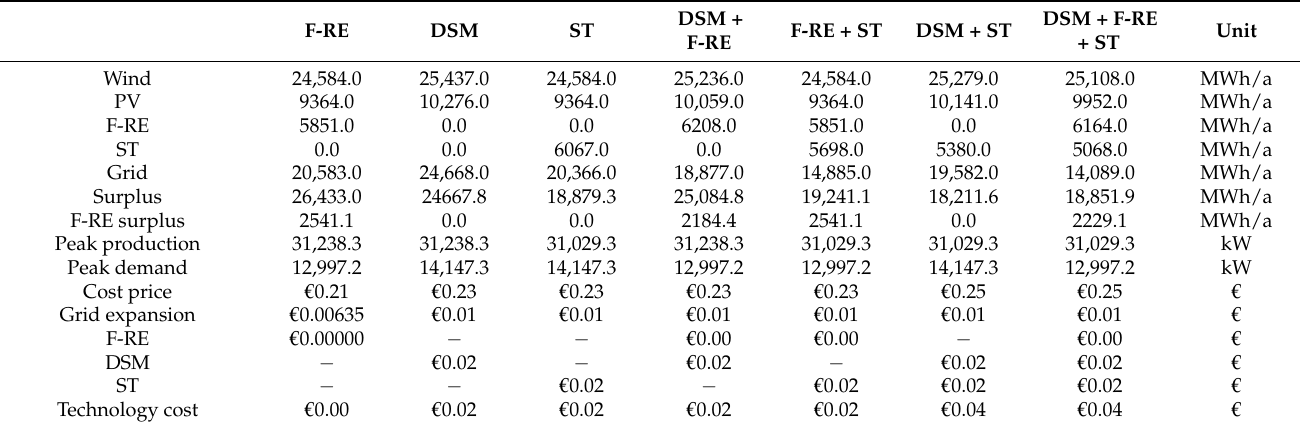
Table A13. Results from the balancing technologies